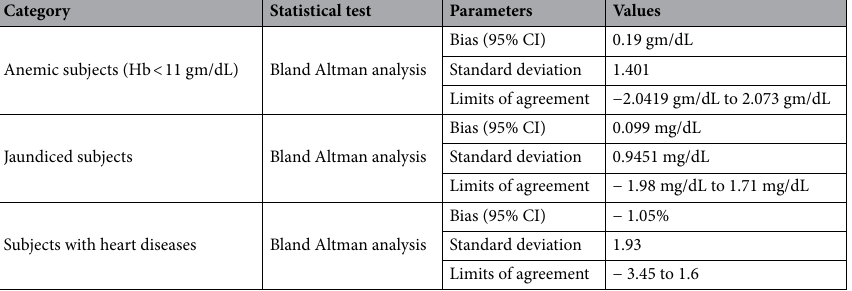
Table 4. Statistical parameters defining the correlation between the developed device and the blood test in a diseased